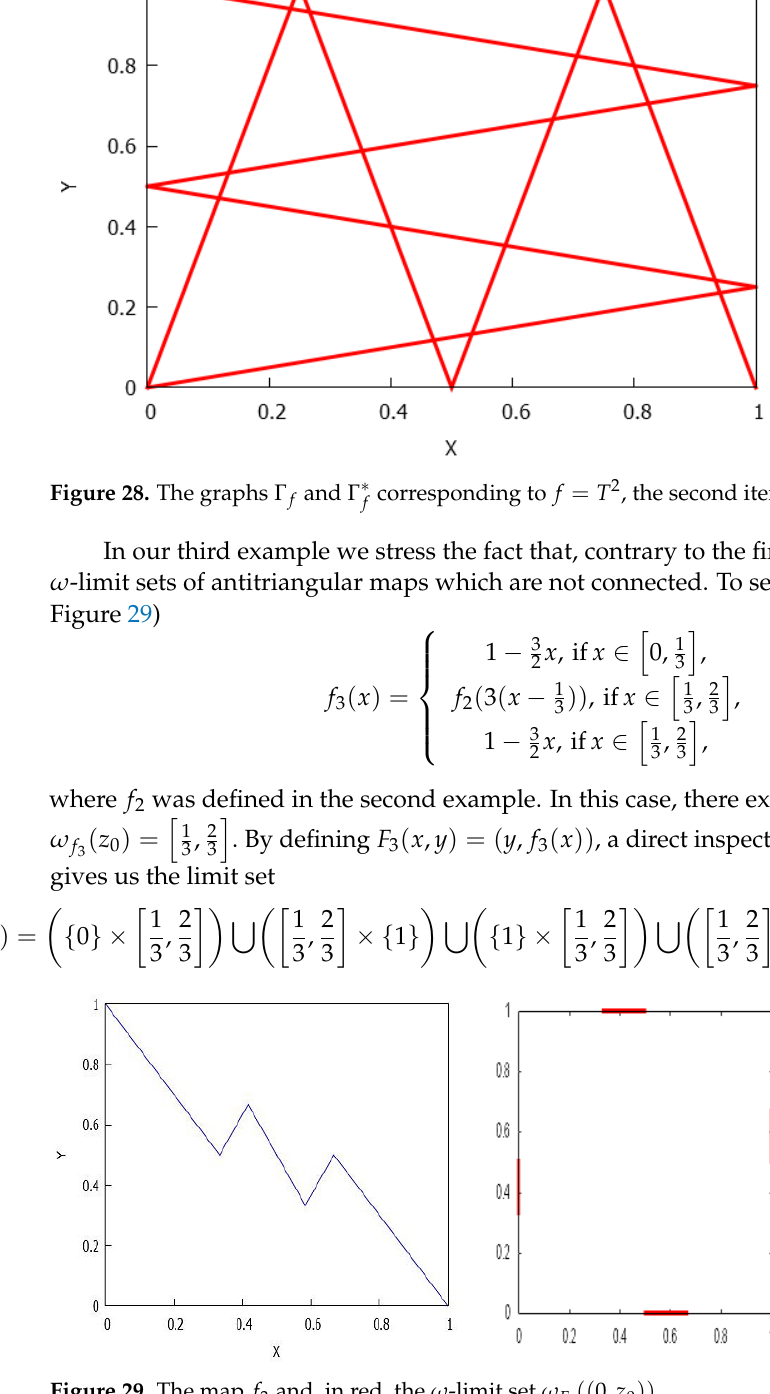
Figure 29. The map f 3 and, in red, the ω -limit set ω F